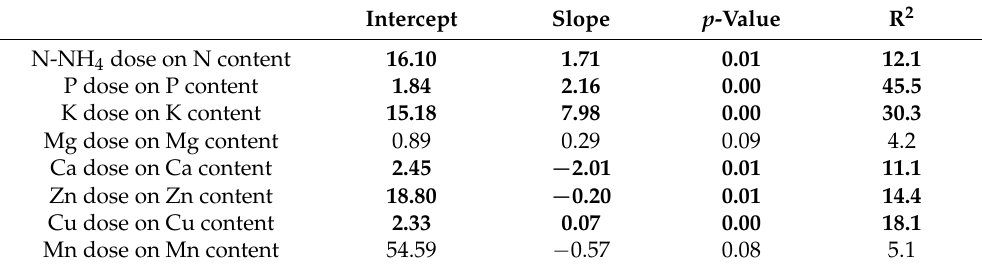
Table 7. Results of linear regression analyses describing the relationship between nutrient contents in maize and nutrient dose in different forms of